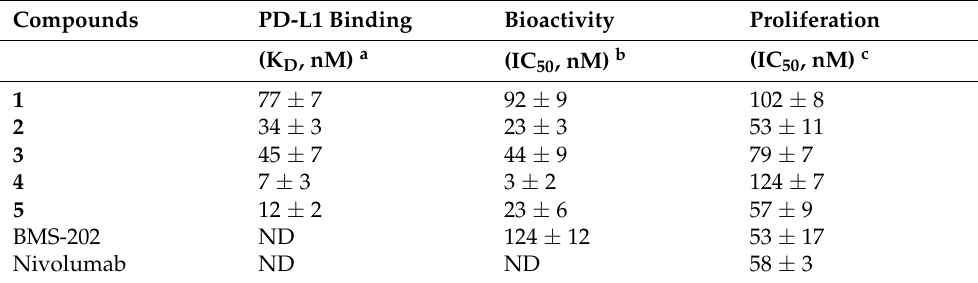
Table 1. PD-L1 binding and regulatory properties of the test